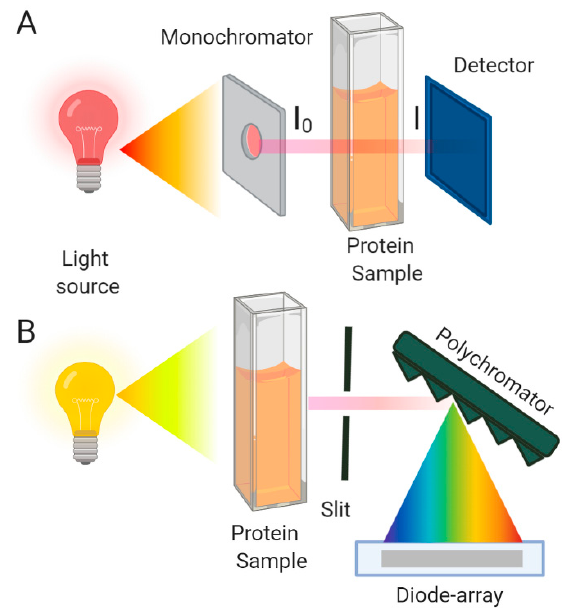
Figure 2. Schematic representation of the process of absorbance and the instrumentation used. Diagrams of ( A ) conventional and ( B ) photodiode array spectrophotometers. The image was created with Biorender.com.